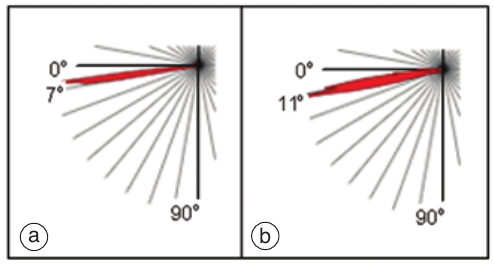
Fig. 9a,b. Inclination changes (expressed in degrees) of the polarization vector at the beginning of the effu- sive phase (STR6 station): a) the 24-h interval before the effusive phase (February 25, 2007, 00:00-February 26, 2007, 00:00; 594 VLPs); b) the 24-h interval after the beginning of the effusive phase (February 27, 2007, 12:00-February 28, 2007, 12:00; 341 VLPs). The inclination increased by